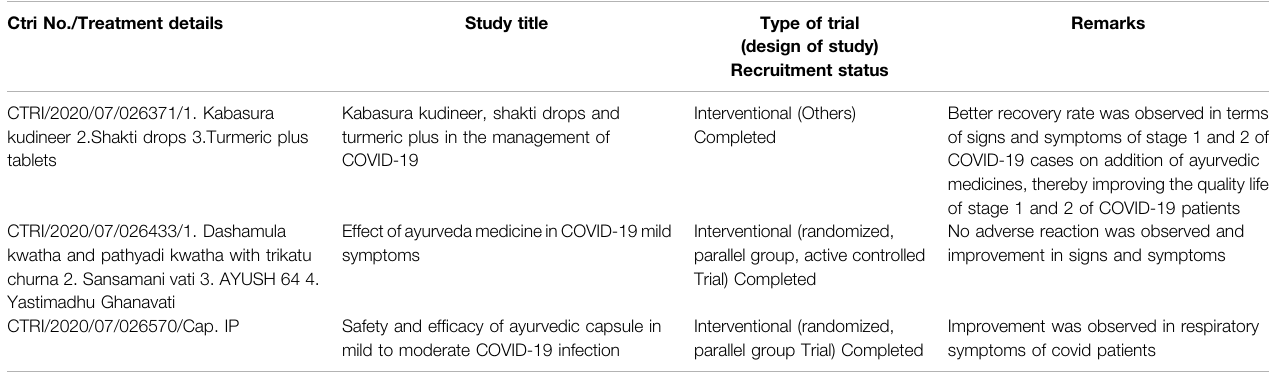
TABLE 1 | ( Continued ) Details of clinical trials completed on AYUSH drugs for COVID-19 (Source: